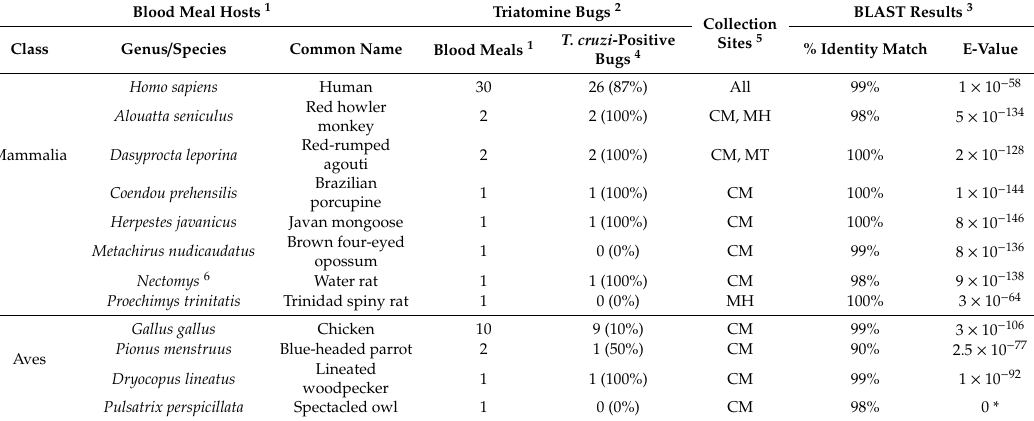
Table 2. Blood Meal Species Identified in Triatomine Bugs Collected, and T. cruzi Infection Status of the Bug or Bugs Corresponding to Each Species. All Data Are Available in File S1, Including Accession Numbers and